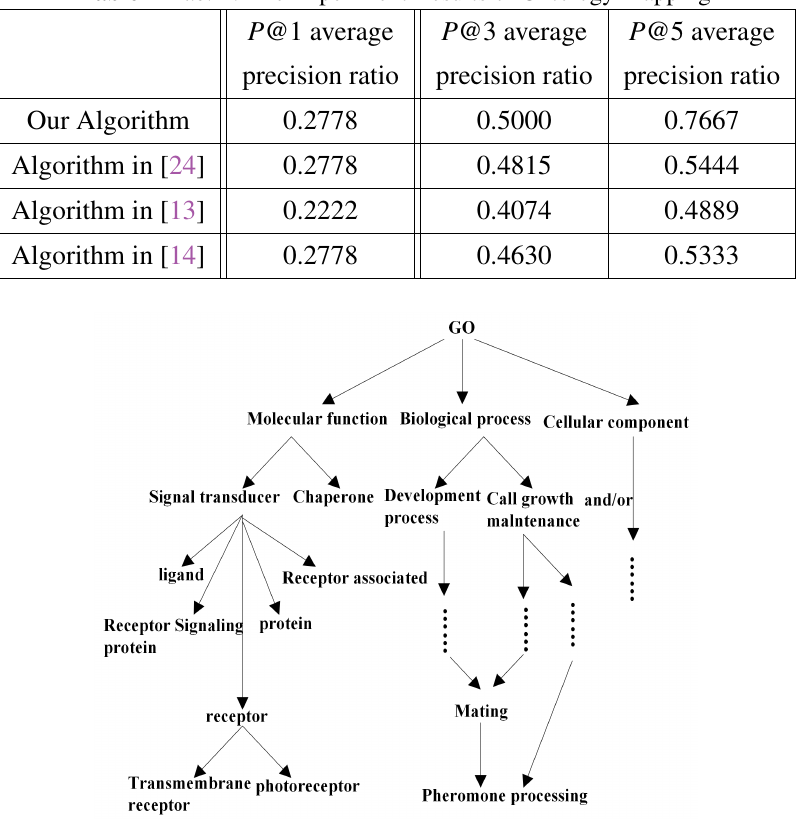
Table 2 Tab. 2. The Experiment Results of Ontology Mapping